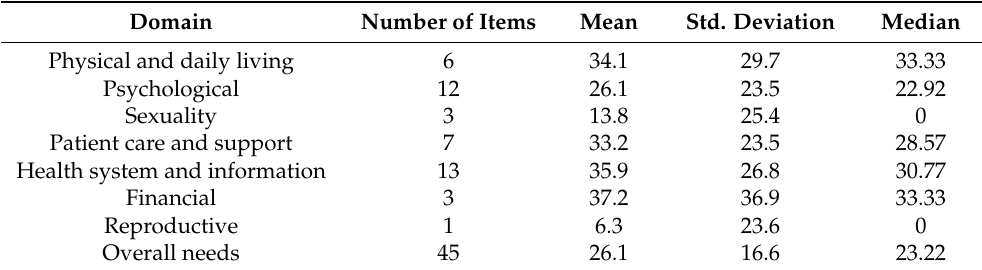
Table 2. Overall standardized scores by domain for the modified SCNS-SF (45